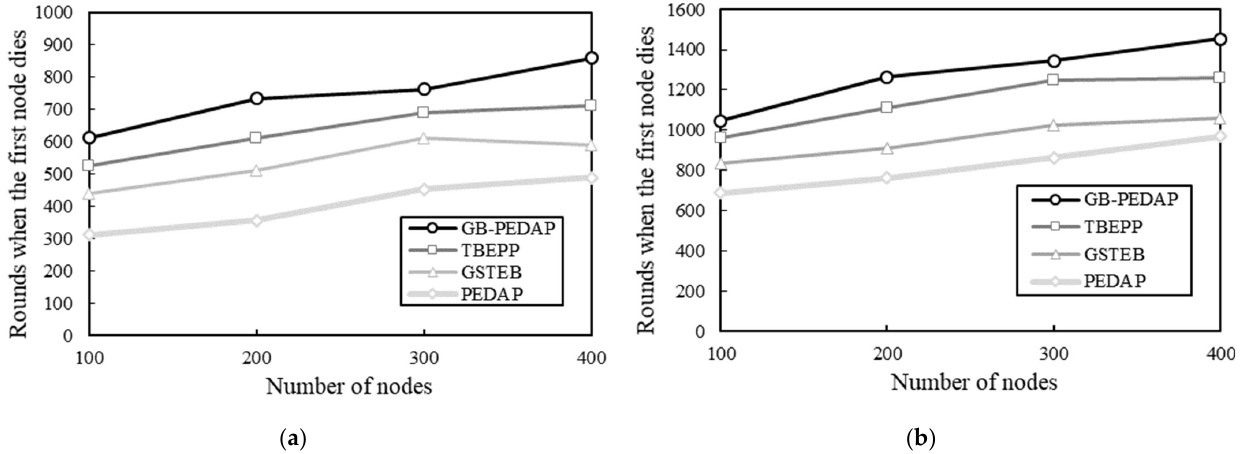
Figure 5. Number of rounds when the first node dies under different numbers of nodes: ( a ) initial energy is 0.25 J; ( b ) initial energy is 0.5 J.